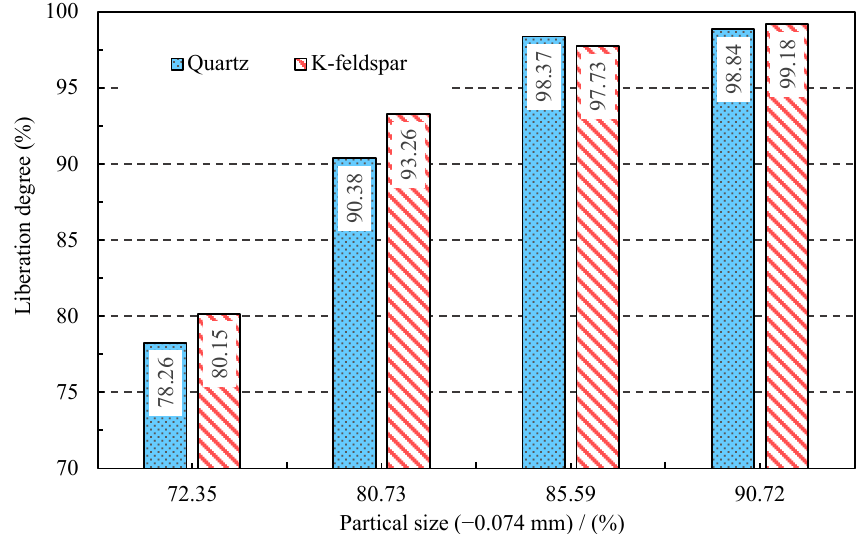
Figure 6. Liberation degree of quartz and K-feldspar in samples with different particle sizes.